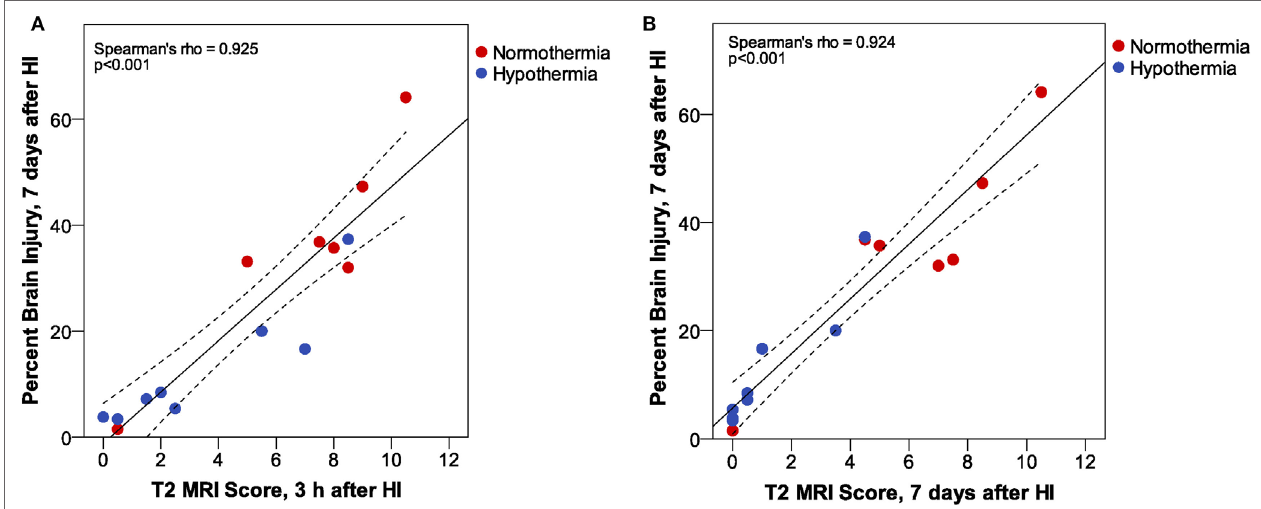
FigUre 6 | Phase 3: T2 magnetic resonance imaging (MRI) scores at (a) 3 h or (B) 7 days after hypoxic ischemia (HI). At both MRI time points, we found a very strong correlation between MRI score and histopathologic brain injury at 7 days. However, inspection of the correlation plots reveals less sensitivity for detection of subtle injury in MRI scores at 7 days. MRI scores are generally lower at 7 days than at 3 h after HI, and the subtle atrophy that is detected by quantitative histopathology is not readily apparent in T2 MRI at 7 days. (Dashed lines show 95% confidence interval for the